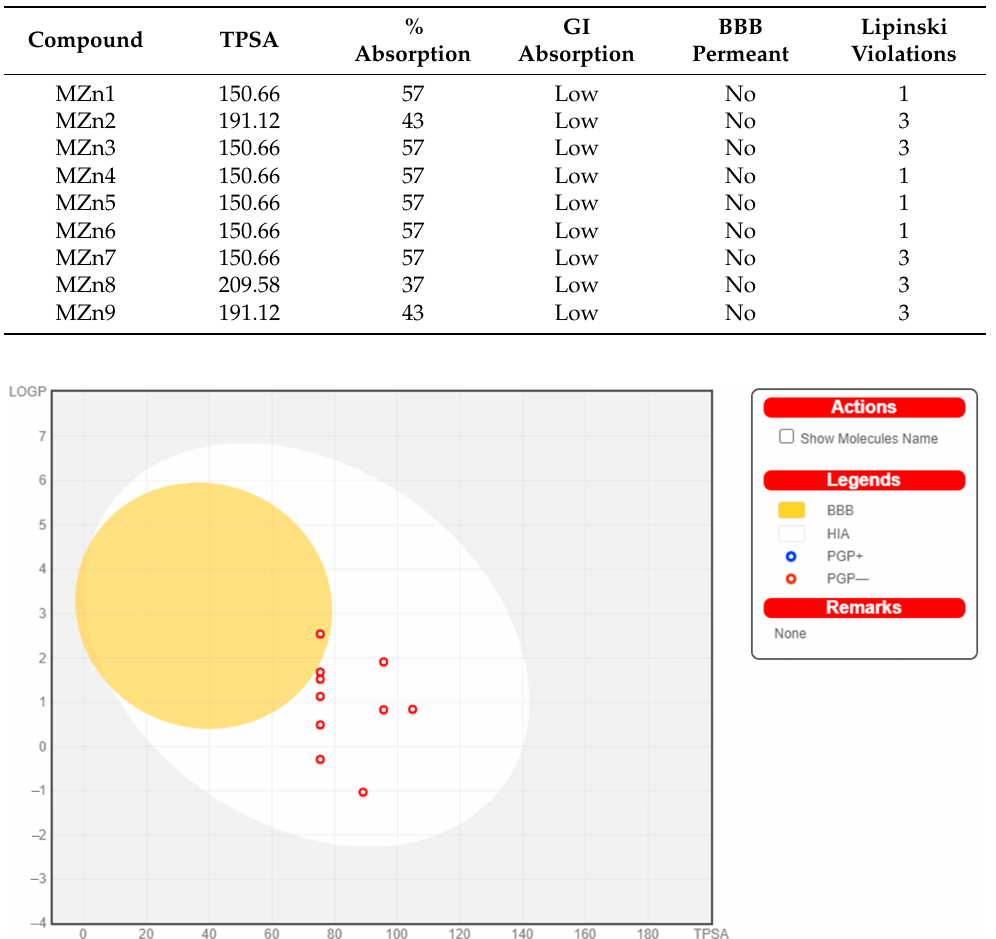
Figure 1. Swiss ADME Analysis of Met1–Met9 (egg plot). Table 2. Swiss ADME of MCu1–MCu9.